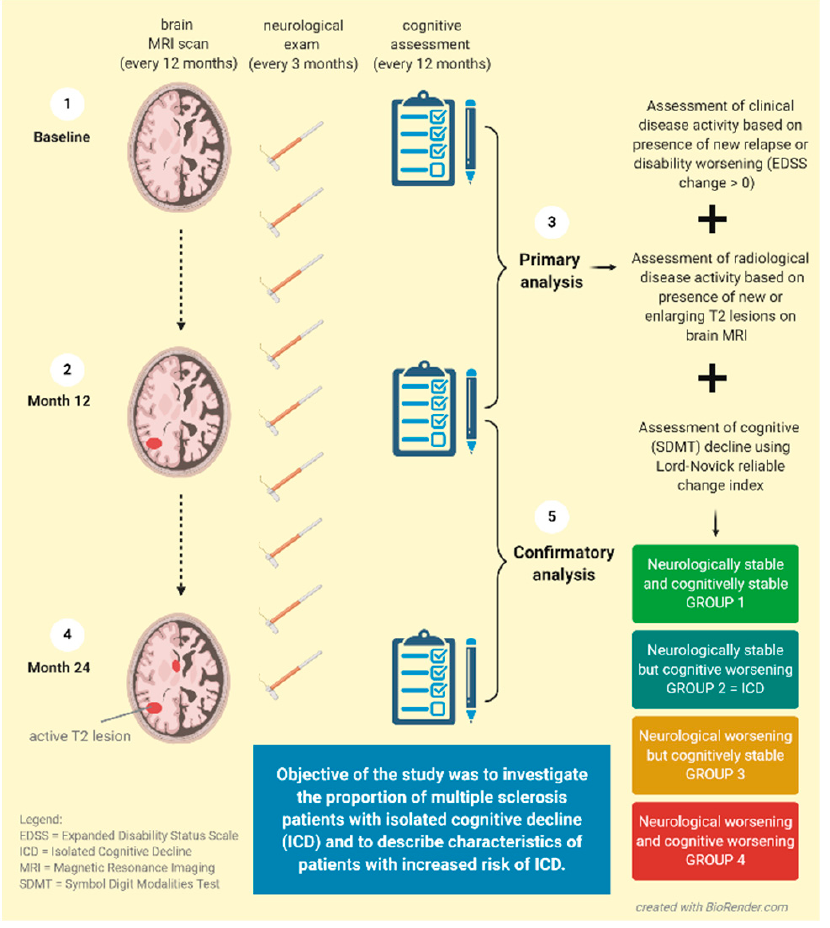
Figure 1. Design of the Study and Analysis.